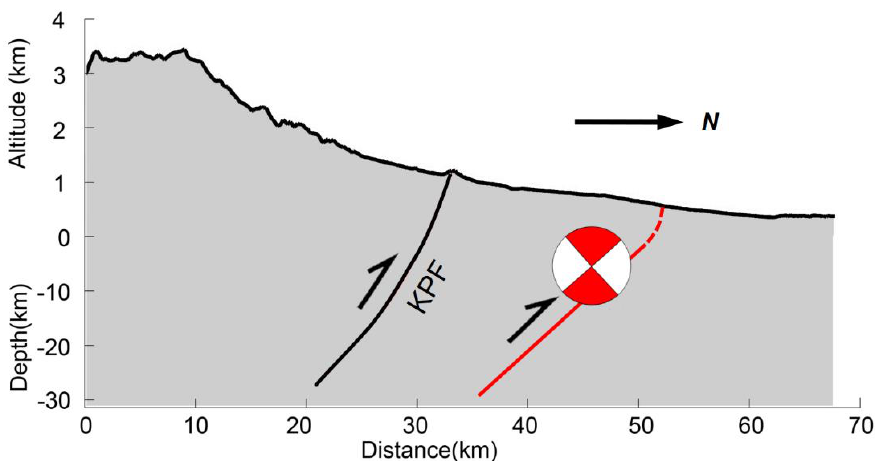
Figure 9. Model of the genetic mechanism of the 2017 Mw 6.3 Jinghe earthquake. The bold red line denotes the seismogenic fault suggested by this study; the dashed red line denotes the speculative upper part of this fault; the side view of the focal mechanism solution denotes the type of event. KPF — Kusongmuxieke Pediment Fault.